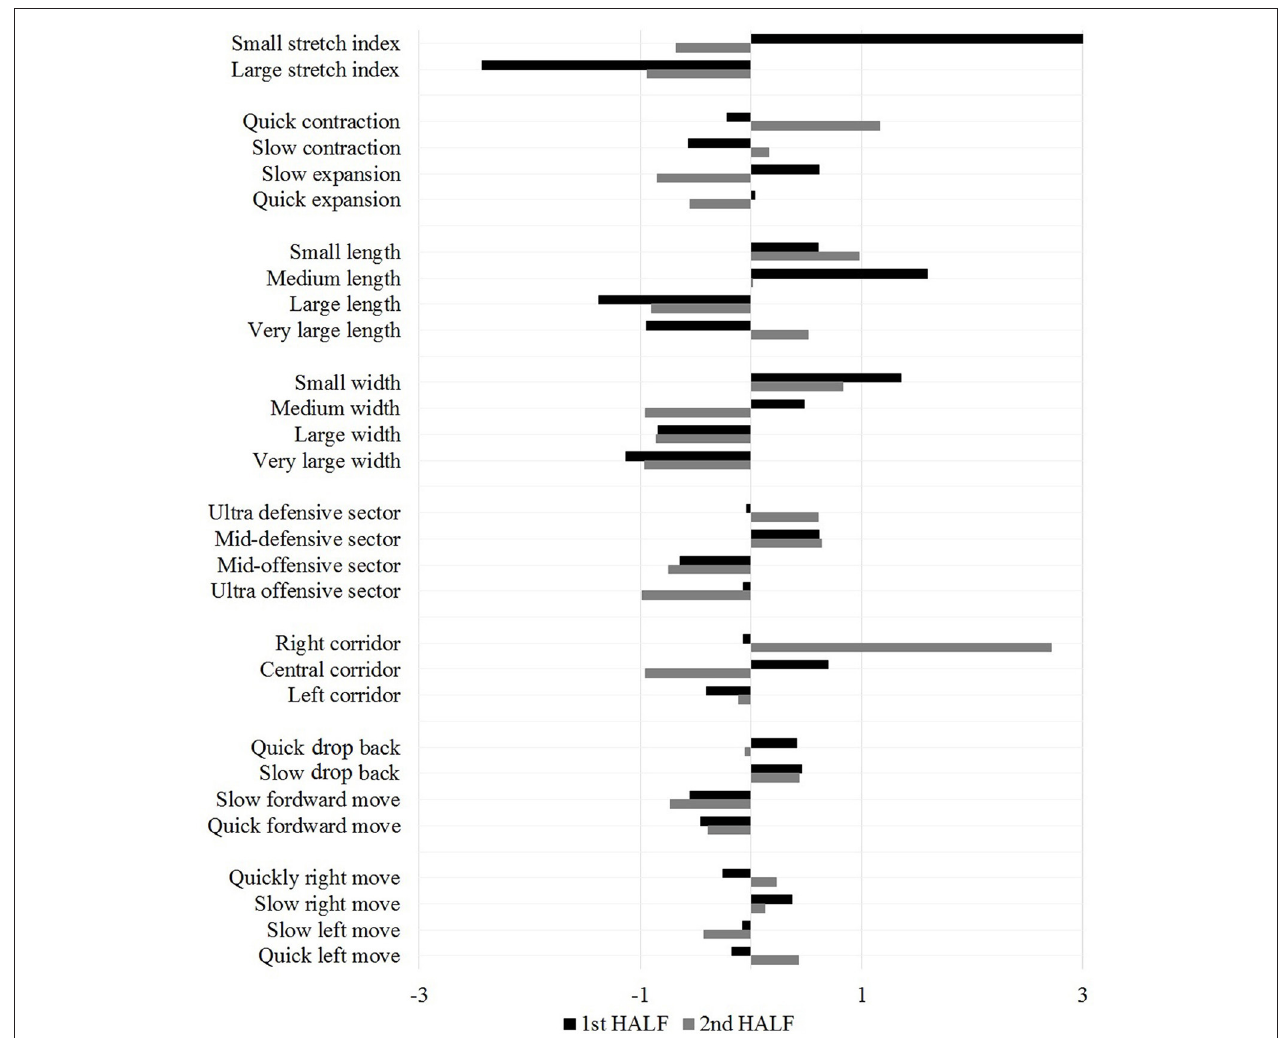
FIGURE 4 | Component scores of the highest level PC for the first and second half.